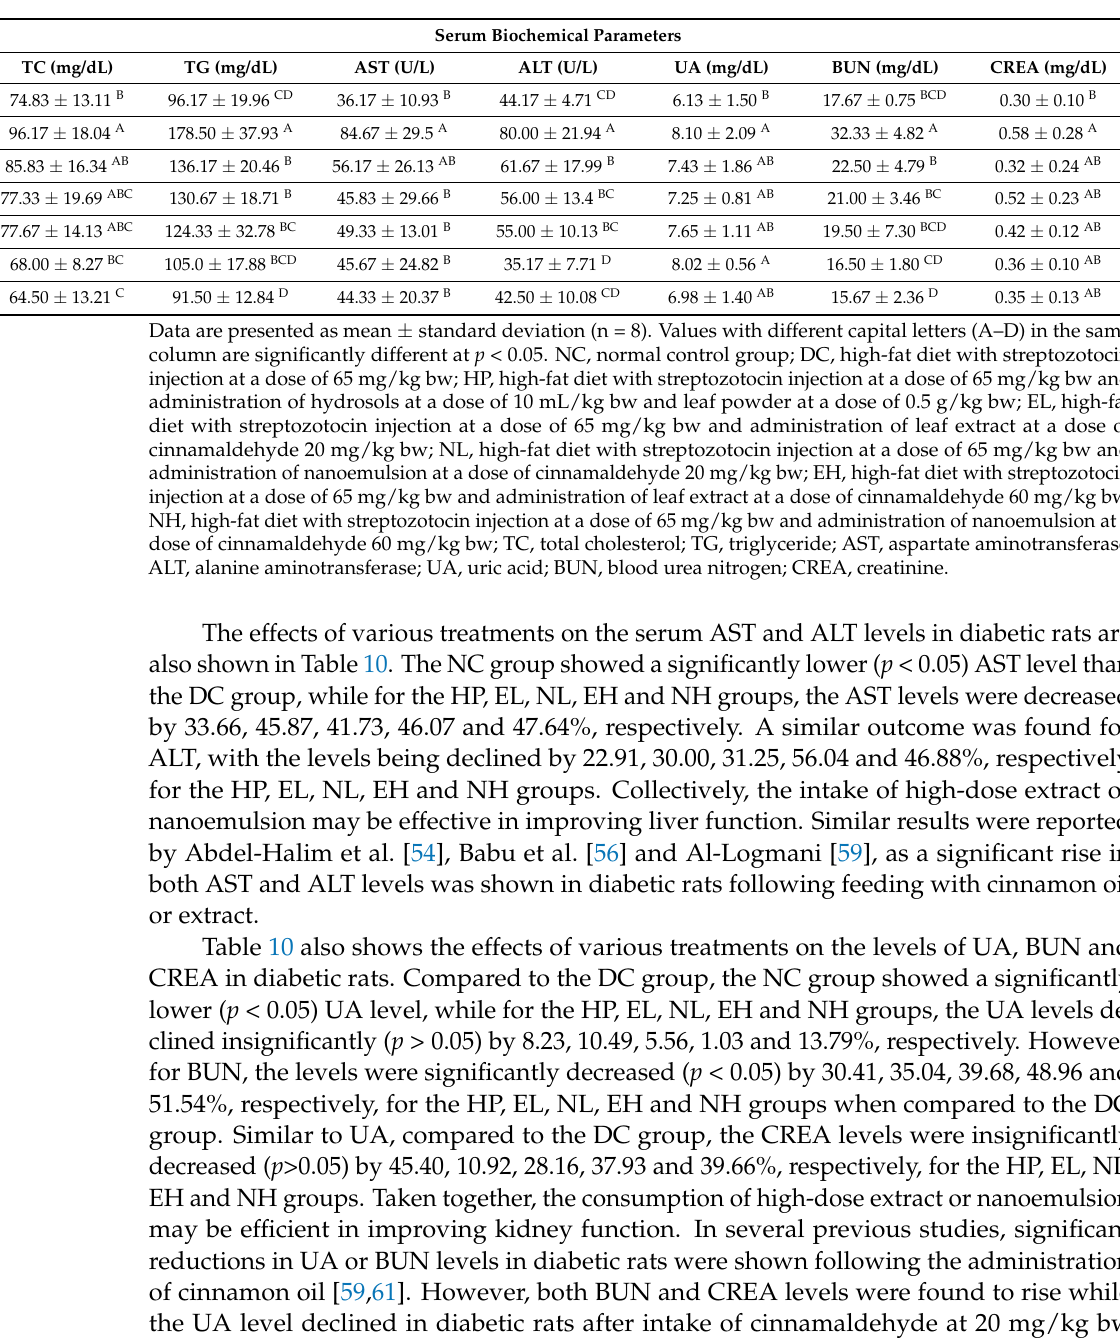
Table 10. Effects of the administration of C. osmophloeum leaf extract, nanoemulsion and hydrosol for 4 weeks on serum biochemical parameters of rats on a high-fat diet that received streptozotocin injection to induce